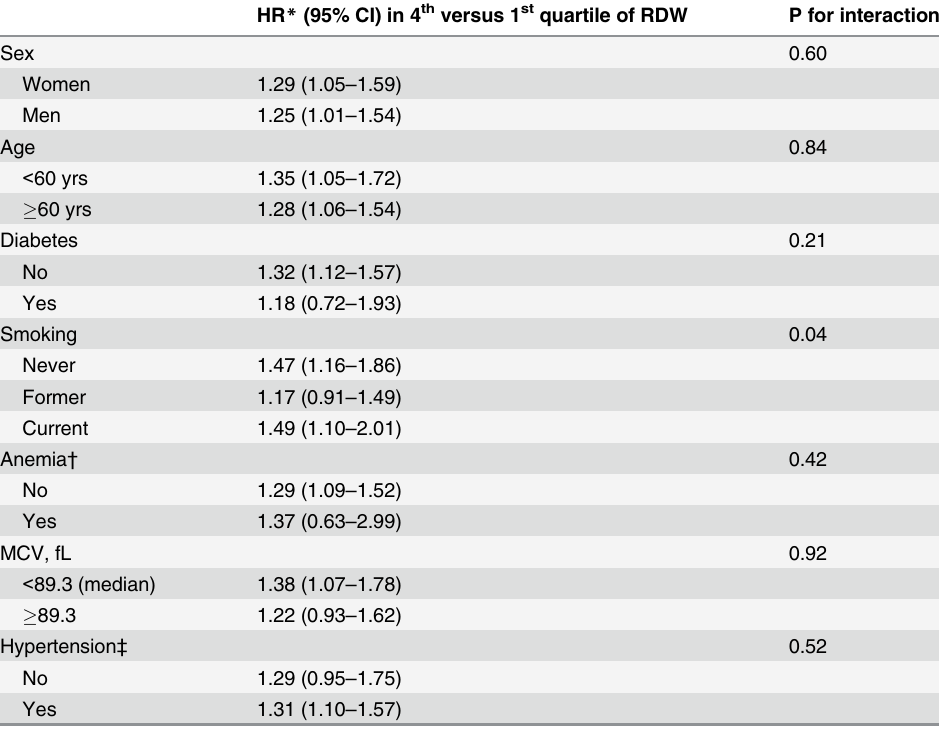
Table 3. Association between red cell distribution width (RDW) and total stroke in selected